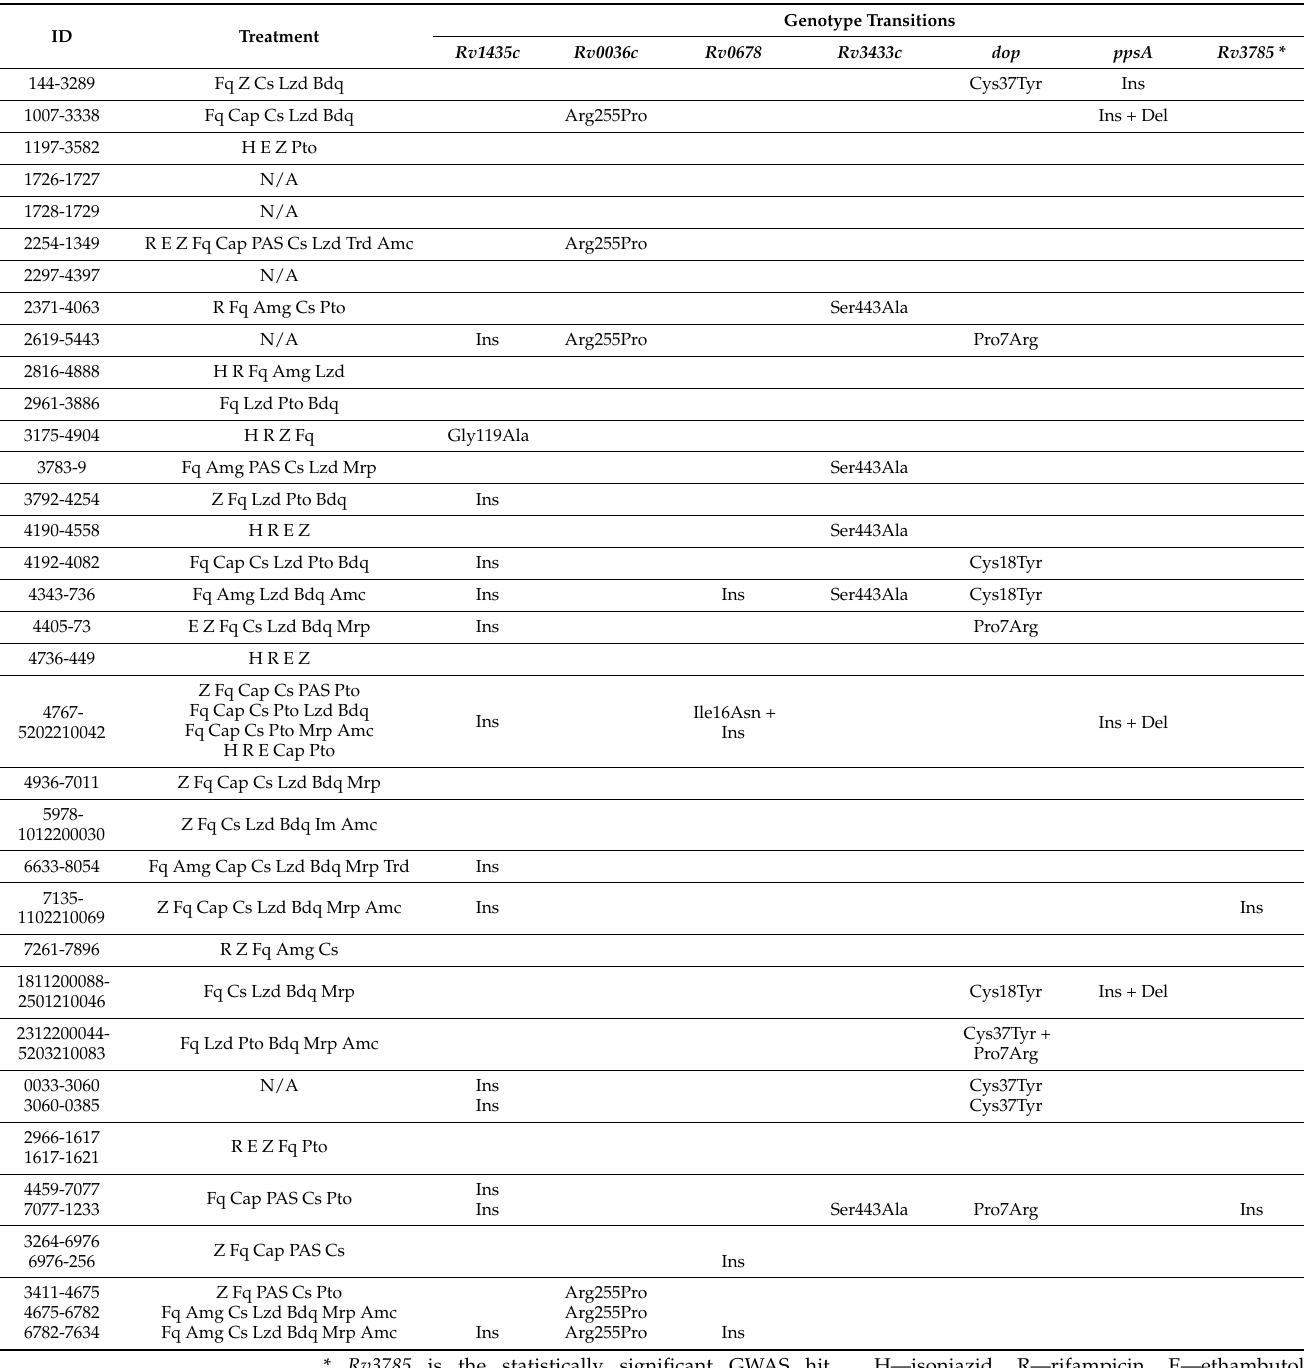
Table 3. Treatment regimens and emerged genetic polymorphisms in isolates from treated patients compared to pre-treatment